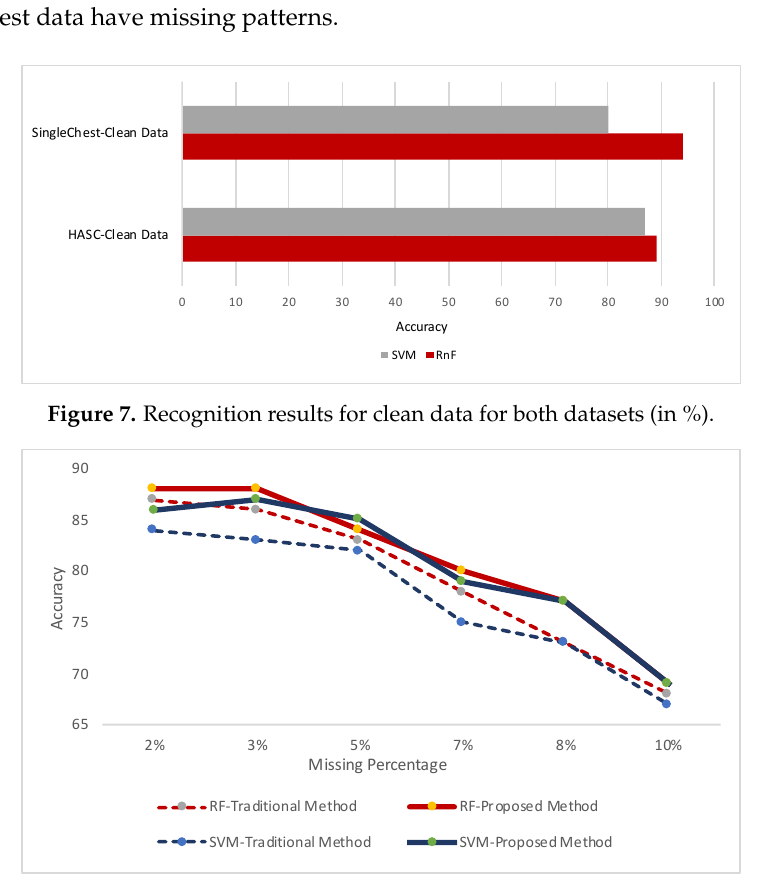
Figure 8. Missing data analysis for activities of human activity sensing consortium (HASC) dataset.